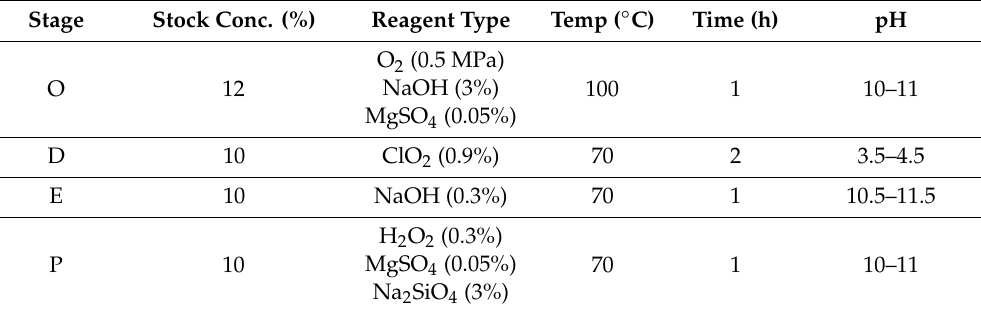
Table 1. Oxygen delignification and elemental chlorine free (ECF) bleaching process parameters. Stage Stock Conc.